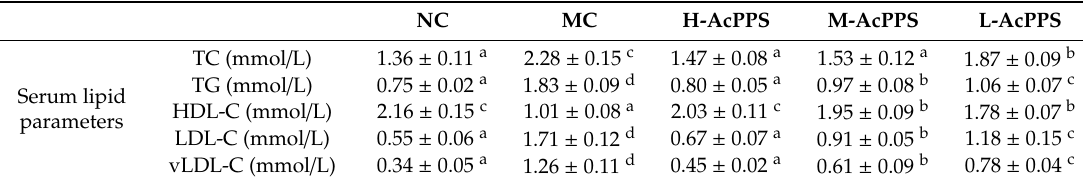
Table 2. E ff ects of AcPPS on lipid peroxidation in ALI